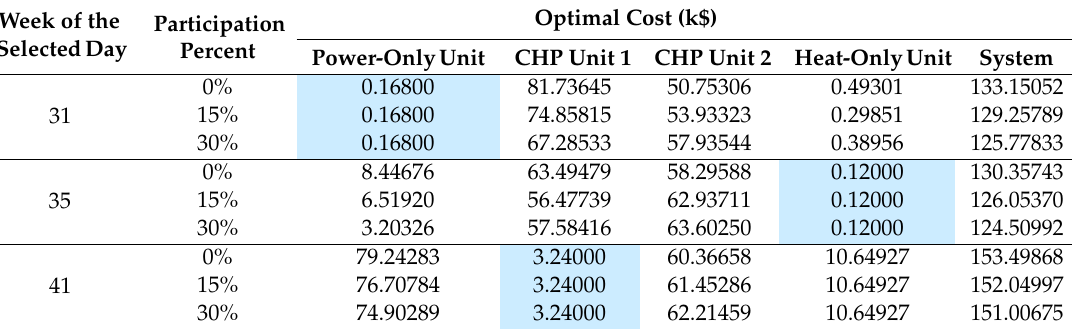
Table 9. The units’ cost for different participation percent in demand response for typical days in the weeks 31, 35, and 41.